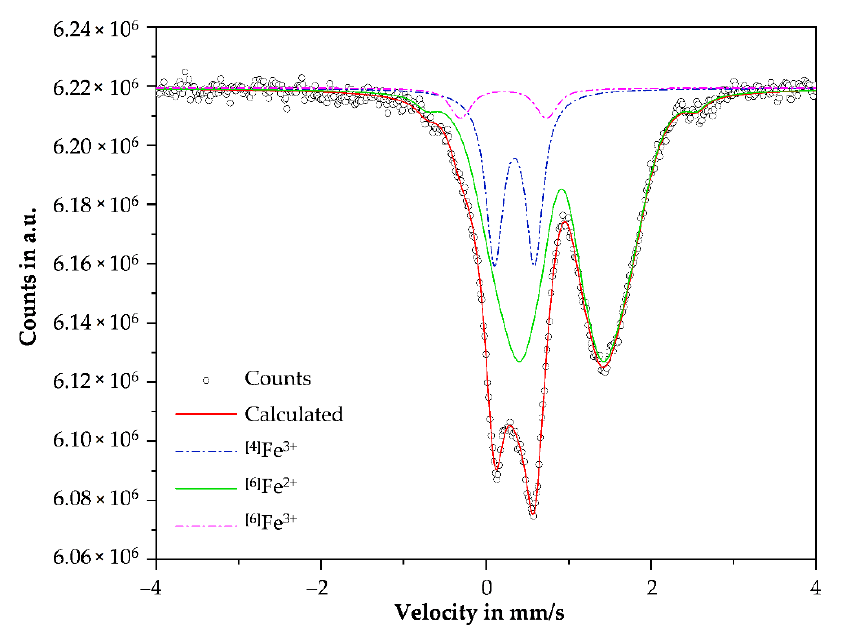
Figure 6. 57 Fe-Mössbauer spectrum of chromite sample.